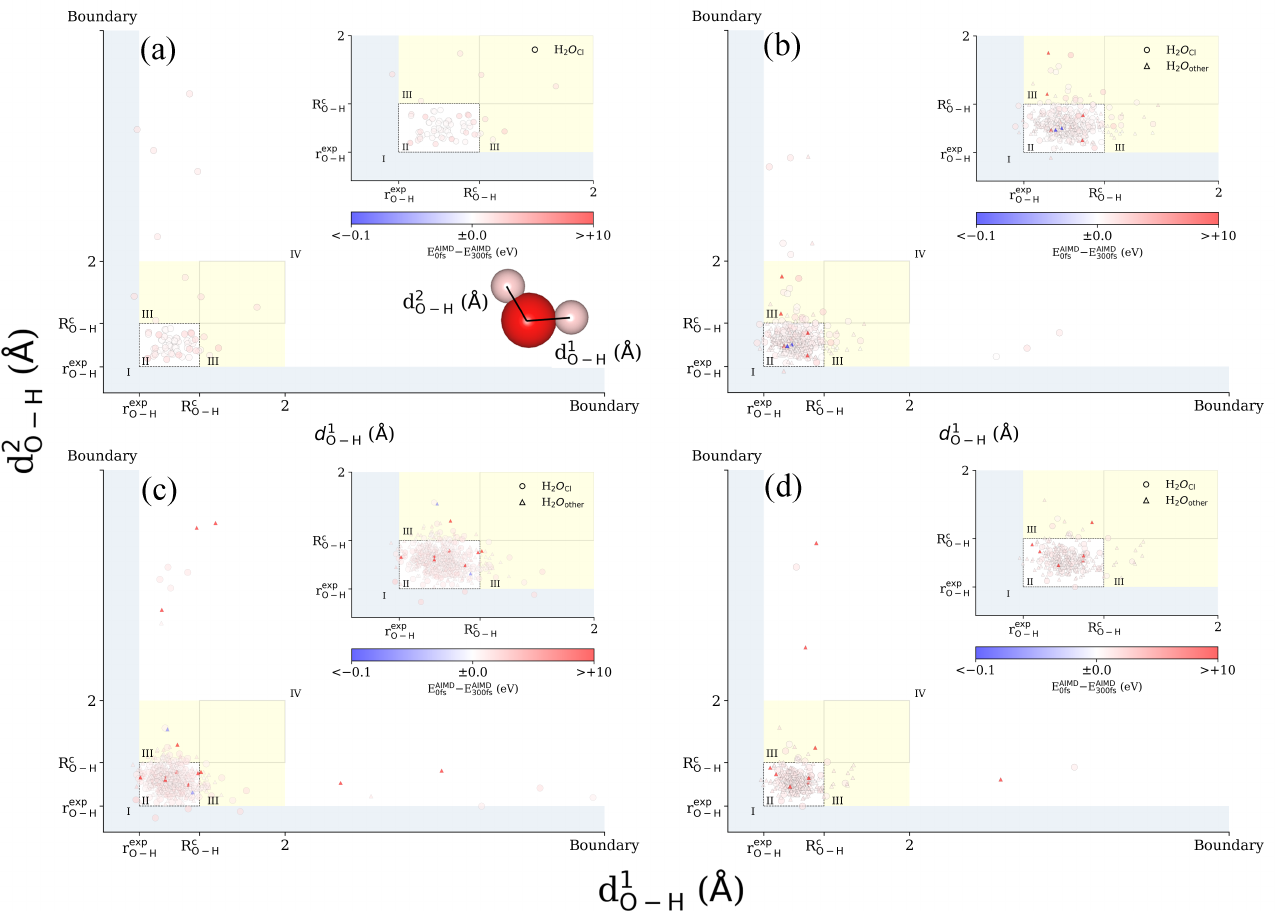
Figure 2. Bond–length (d O − H ) distributions for each water molecule correlation to the total energy difference between the initial and final configurations after AIMD. The four diagrams of ( a – d ) individ- ually represent the types of rutile (110) surface with one, two, three, or four H 2 O adsorbates according to the Figure 1c–j, respectively. The illustration of water bond-lengths is the insets in ( a ). The criteria of bond-breaking are determined by the coordination number cutoff R C 0.9572 Å for isolated water molecule in vacuum [51]. The boundary is set to be 10 Å. The insets are the zoom-in view around the criteria of bond-breaking. The energy difference between the initial (0 fs) and the final (300 fs) AIMD state is represented by the colour intensity on blue–red